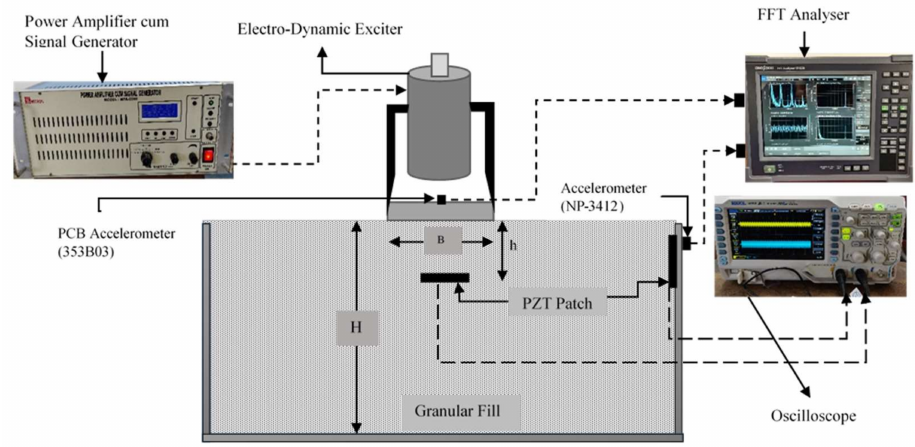
Figure 2. Laboratory experimental set-up for dynamic response and voltage measurement.